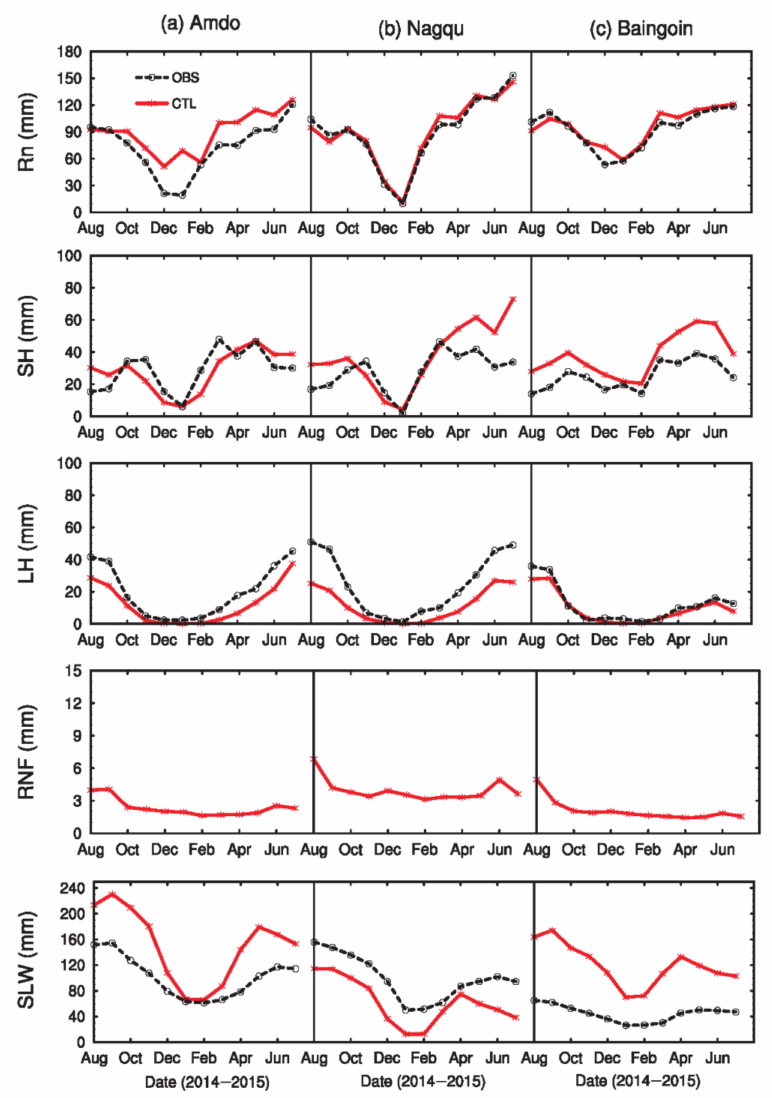
Figure 9. Comparison between the observed (OBS) and simulated hydrological cycles for the selected optimal scheme combinations in CTL at the ( a ) Amdo site, ( b ) Nagqu site, and ( c ) Baingoin site. Subfigures from top to bottom show the monthly total net radiation (Rn), monthly total sensible heat flux (SH), monthly total evaporation (LH), monthly total runo ff (RNF), and monthly averaged 0–1 m total soil liquid water